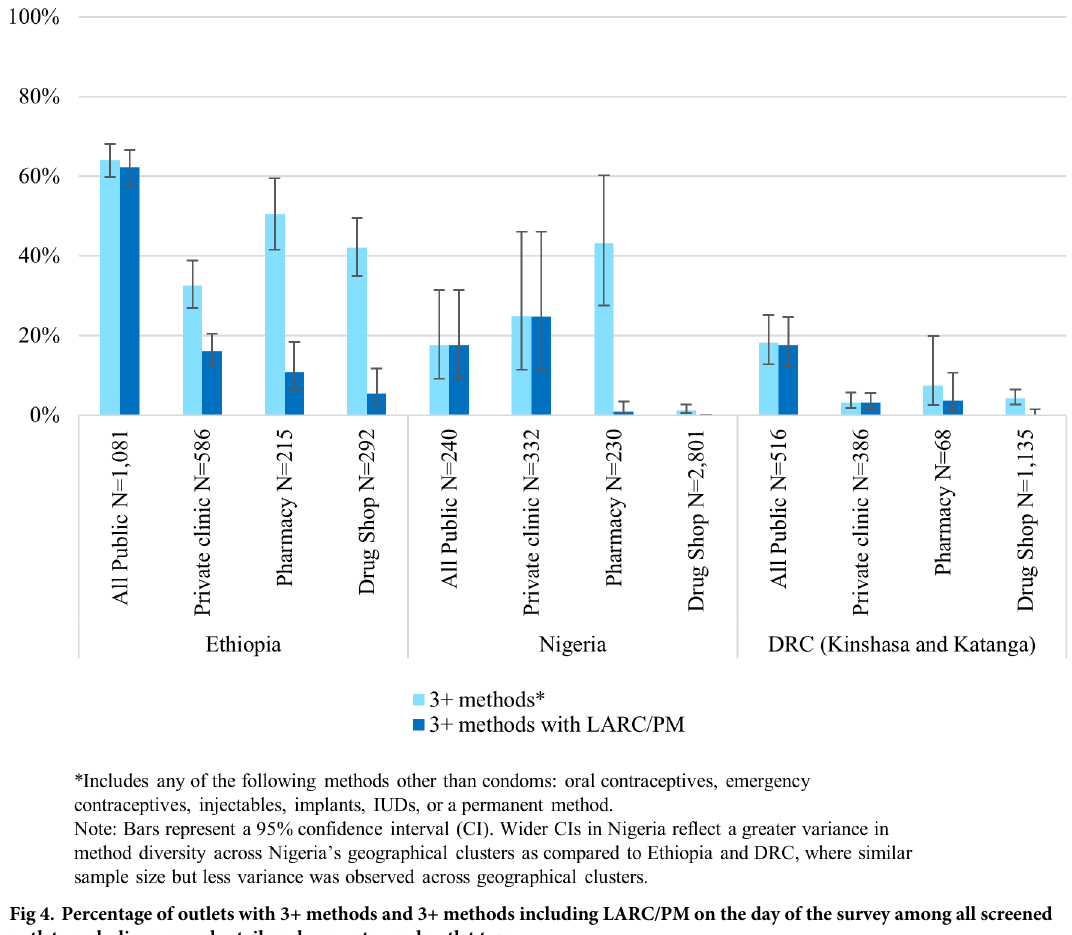
Fig 4. Percentage of outlets with 3+ methods and 3+ methods including LARC/PM on the day of the survey among all screened outlets excluding general retailers, by country and outlet